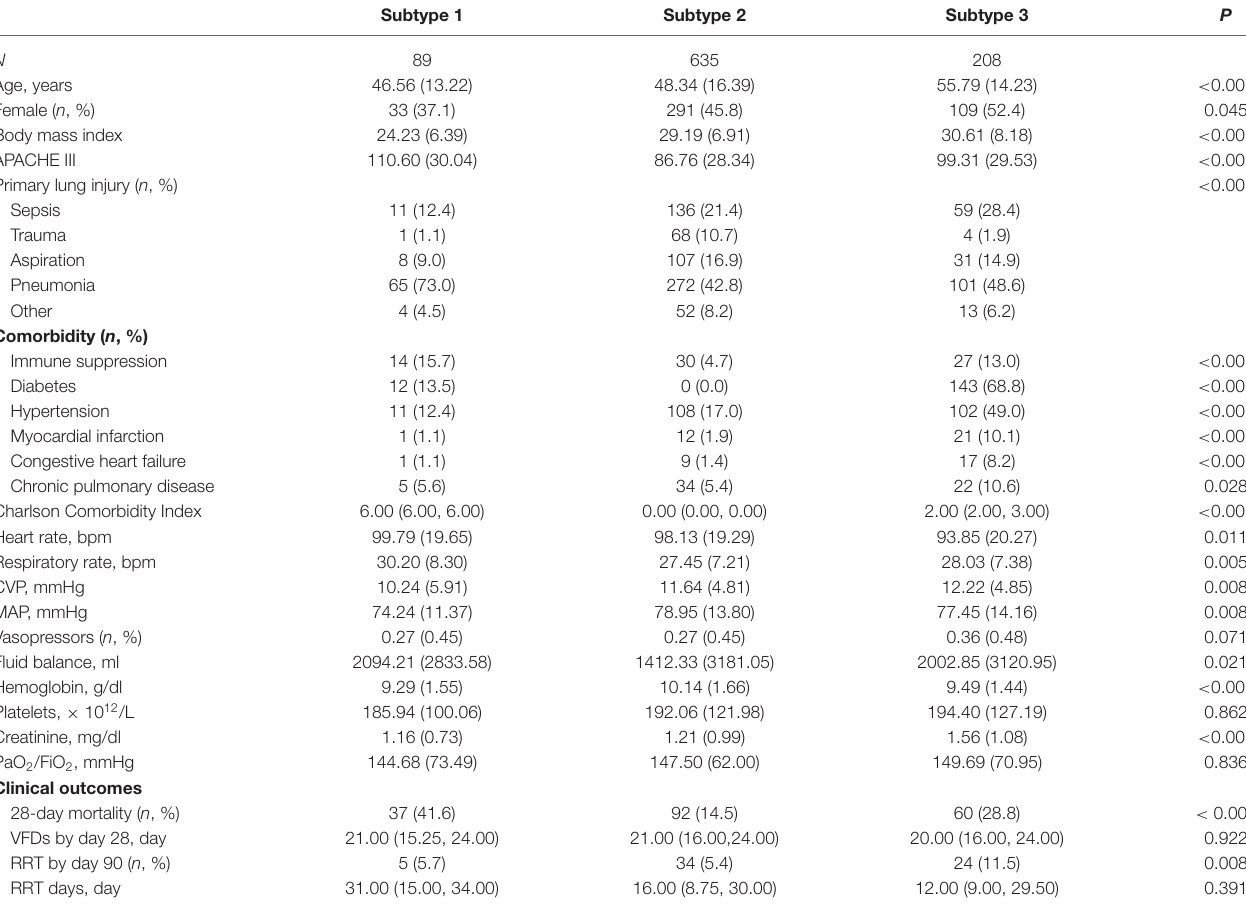
TABLE 3 | Comparisons of the baseline and clinical characteristics between the subtypes.